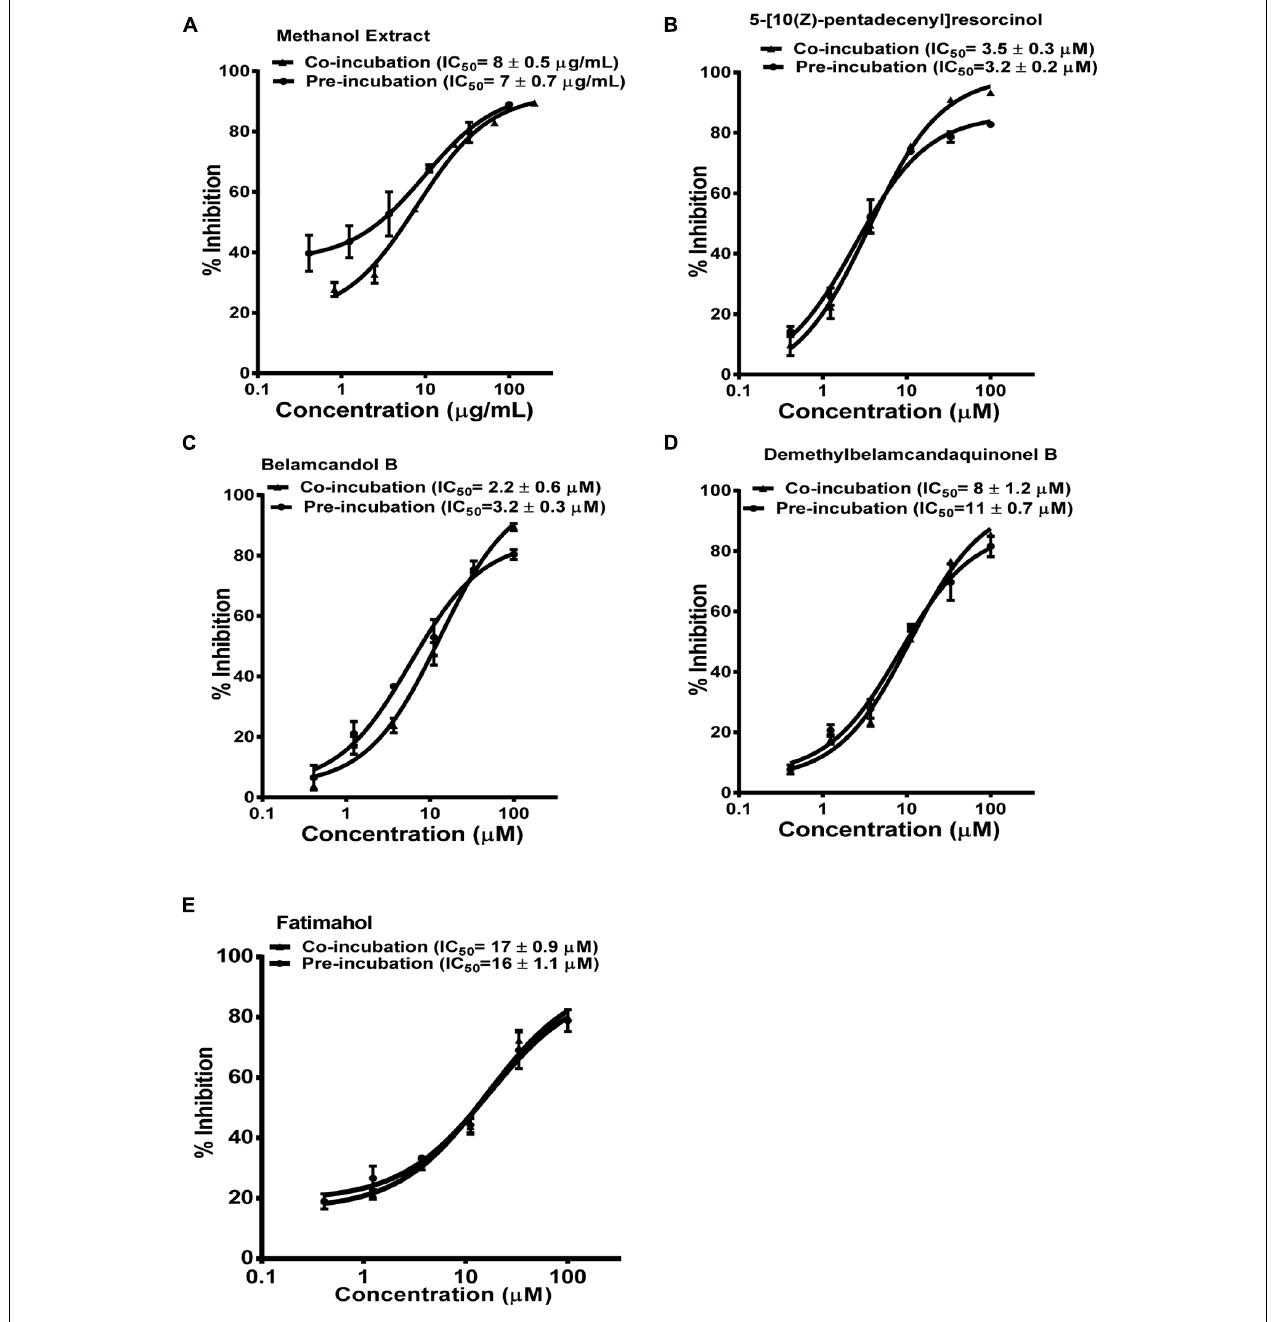
FIGURE 4 | Dose response profiles of reversible andTDI of CYP2C19 enzyme by Labisia pumila root extract (A) and its alkyl phenolic constituents (B–E). The data are represented as mean ± SD of 3 independent experiments ( n = 2 in each experiment).